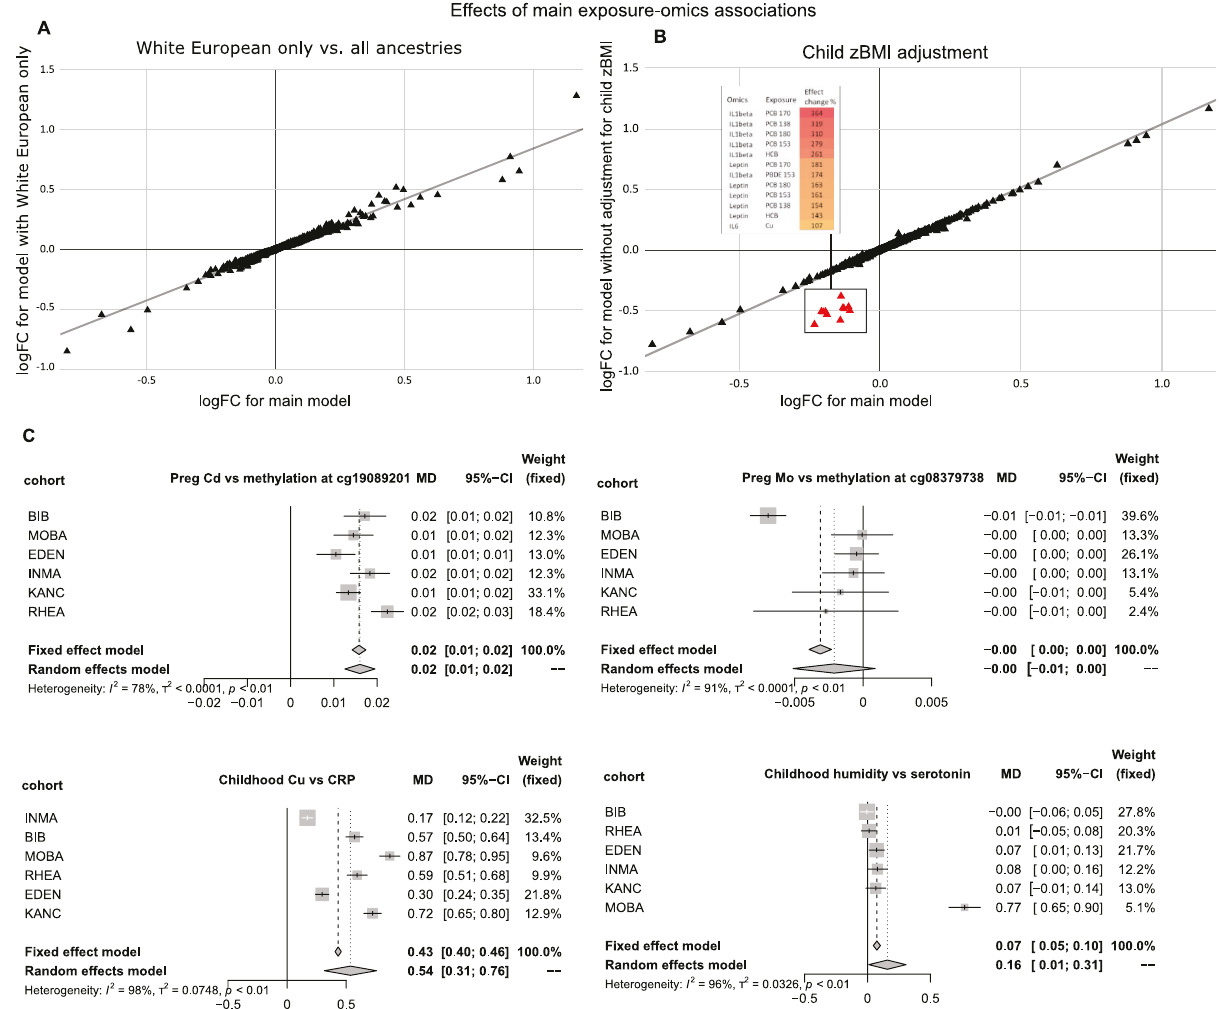
Fig. 3 | Robustness ofmain exposome-omicsassociations. Comparisonof effect sizes of the 1170 exposome-omics associations of the main model, thatincludes all children ( N =1301) and is adjusted for child ’ s zBMI and ancestry, vs. effect sizes of alternative models. Each triangle represents an association. The x -axis represents the effectsize of theexposureonthe omicsfeatureinthe mainmodel,whilethe y - axis represents the effect size in the alternative model. The percentage change in effect size between models is calculated as indicated in the Supplementary Infor- mation. A Alternative modelincluded allcovariates but wasrestricted to European ancestry children ( N =1171). No major differences were observed. B Alternative model included all children and was unadjusted for child ’ s zBMI. Exposure-omics associations with a percent change between models above 100% are coloured in red, and include proteins and child lipophilic chemical pollutants, as listed in the table. C Forest-plots showing the fi xed- and random-effects inverse variance